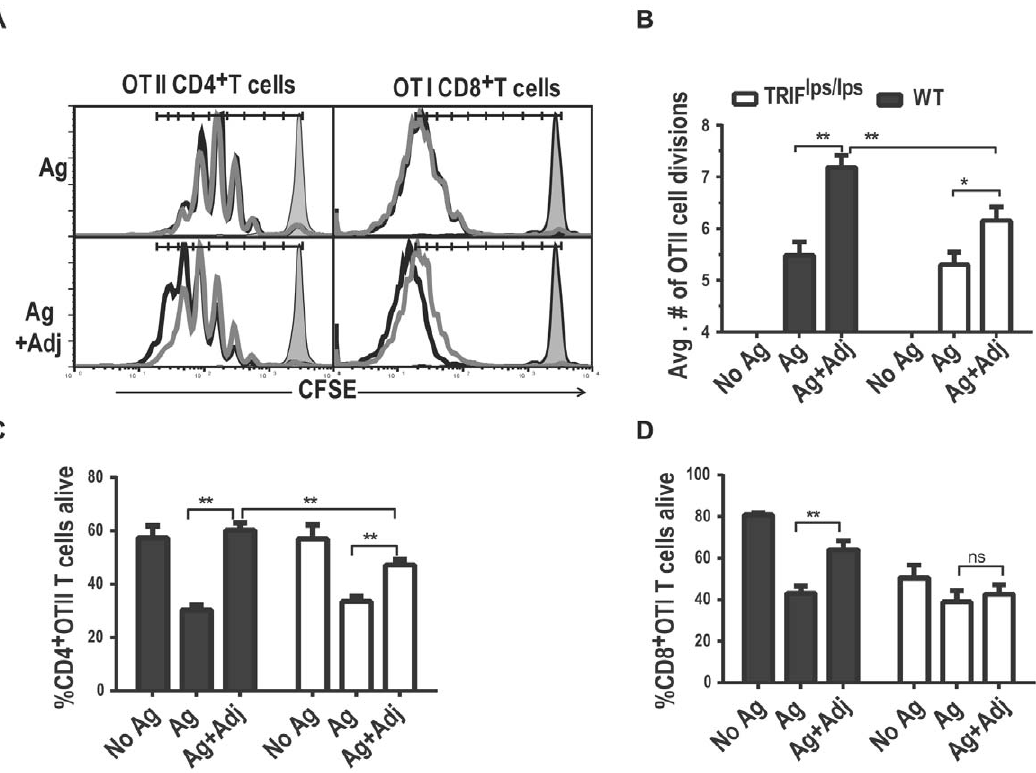
Figure 3. Lipid A adjuvanted T cells in TRIF lps/lps recipients have impaired T cell proliferation, and survival ex vivo under growth factor deprived conditions. CFSE labeled OTI and OTII cells were activated in WT and TRIF lps/lps recipients with antigen alone (Ag), antigen plus lipid A (Ag + Adj), or saline (No Ag) and harvested for flow cytometric analysis 96 h later. A) Histograms show the CFSE profiles of representative replicates after each treatment (black lines, WT; gray lines, TRIF lps/lps ; solid histogram, unstimulated cells obtained at the time of immunization).B) The average number of OTII cell divisions after each treatment were calculated as described in Methods. Results shown are the combined average 6 SEM of 3 replicates from three independent experiments (n=9). C–D) TLR4-induced survival effects on the proliferating T cells were estimated by placing the harvested splenocytes in ex vivo culture under growth factor restricted conditions and testing for viable cells after 9 h (CD8 + OTI cells (C)) or 18 h (CD4 + OTII cells (D)). Data represented are the averages from all 3 replicates from 3 independent experiments. Statistical significance between the treatments was by two-way ANOVA. **; p-value # 0.01 and *; p-value # 0.05. doi:10.1371/journal.pone.0056855.g003 PLOS ONE |